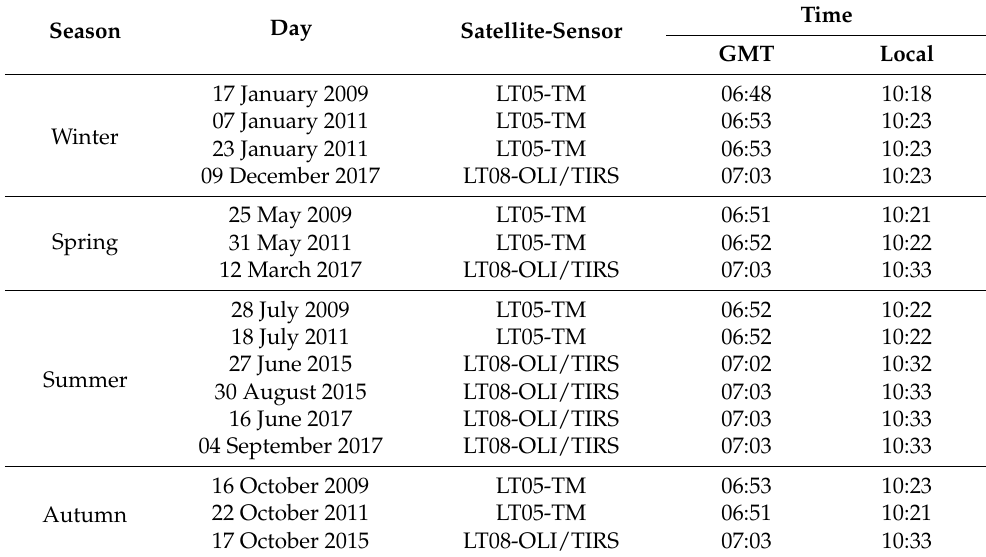
Table 1. Data sets used to derive LST and Tair_calc (calculated air temperature) maps for the study area and the selected 16 days at 06:48 to 07:03